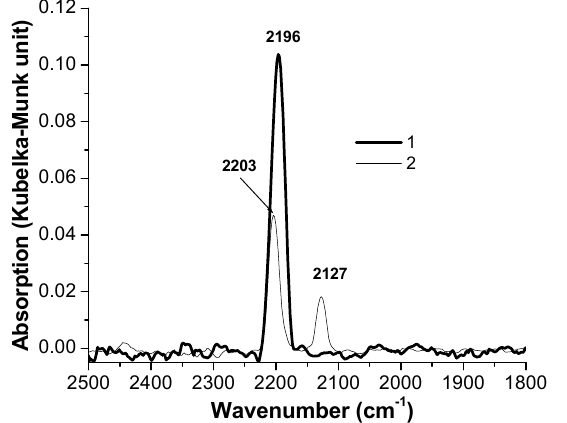
Figure 3. DRIFT-CO spectra measured on the fresh CuO-ZnO-SiO 2 ( 1 ) and CuO-ZnO-SiO 2 -WC ( 2 ) catalysts.